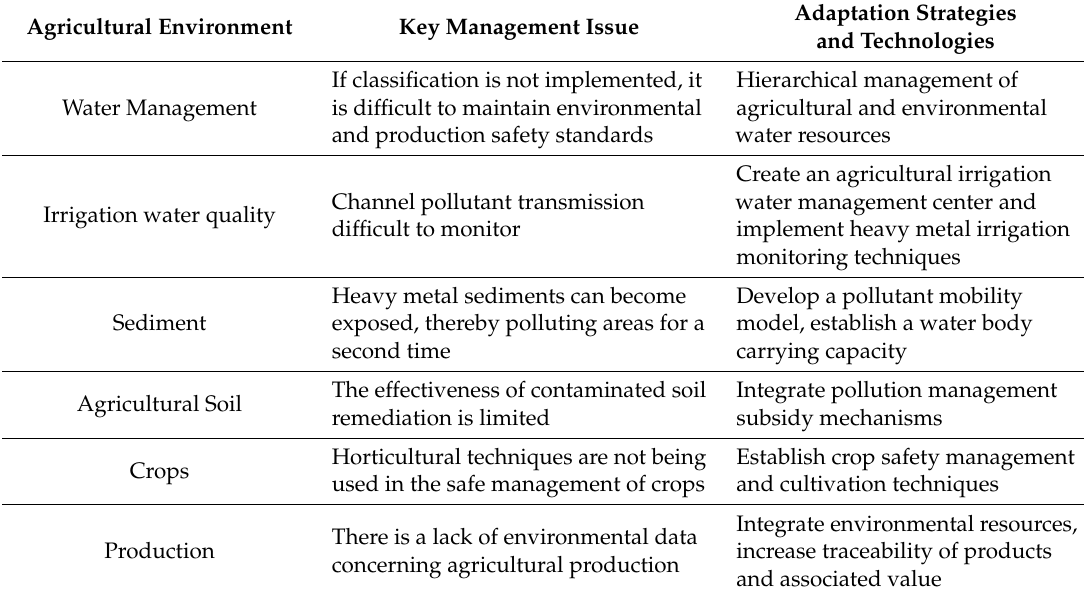
Table 1. Agricultural environmental key issues and adaptation strategies and